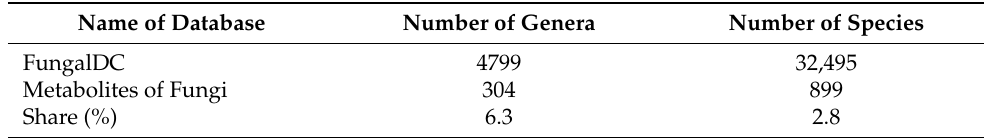
Table 8. Diversity of fungi in culture collections and metabolite database (on 2 June